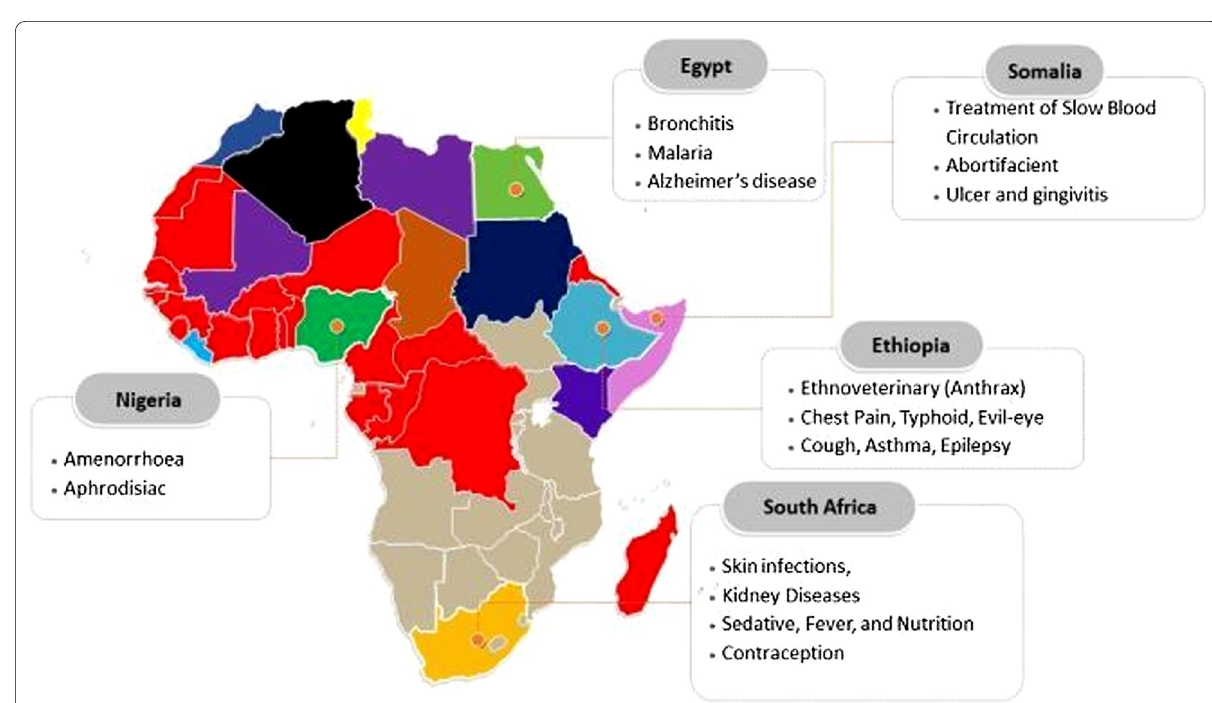
Fig. 2 Ethnomedicinal usage distribution of W. somnifera in African countries and the plant applications in selected